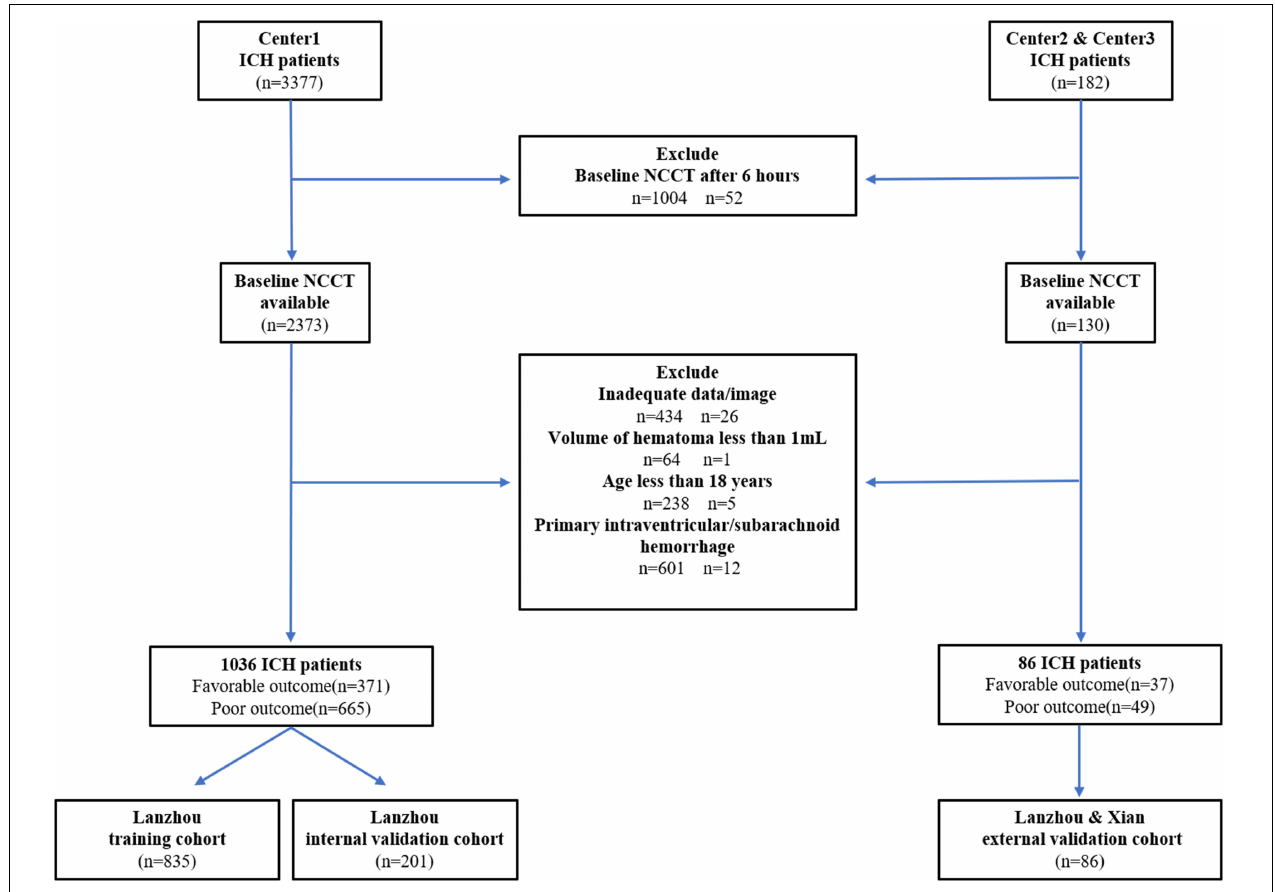
FIGURE 1 | Flowchart of patients’